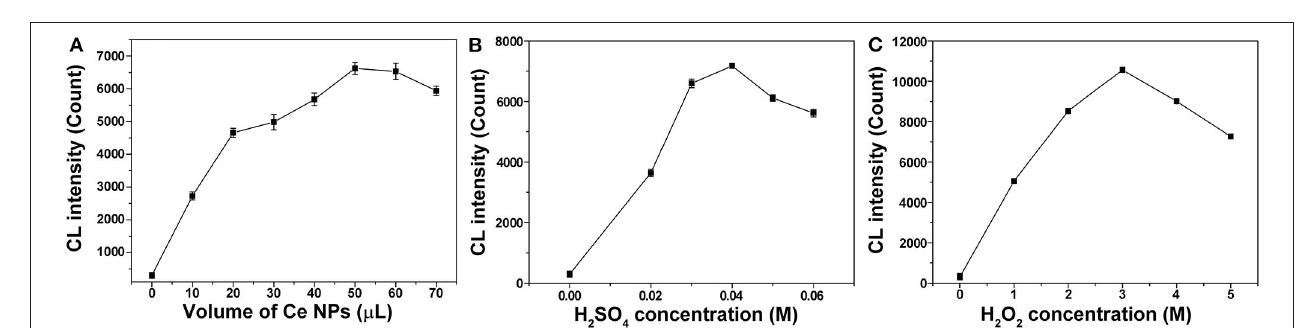
FIGURE 6 | Optimization of experimental conditions for nitrite analysis. (A) Volume of LaF 3 :Ce NPs added into the CL system was optimized. (B) Concentration of H 2 SO 4 used to acidify H 2 O 2 was optimized. (C) Concentration of H 2 O 2 was optimized. The standard error bars mean the variation of three individual experiments.